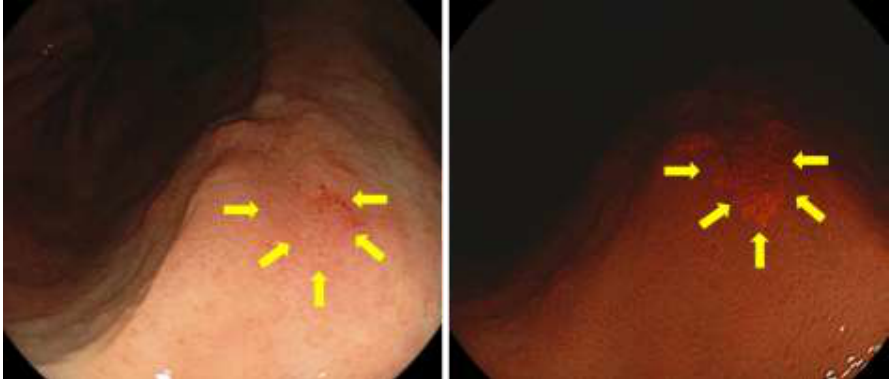
Figure 2. The 5-ALA mediated PDED with Sie-P1 for early gastric cancer.